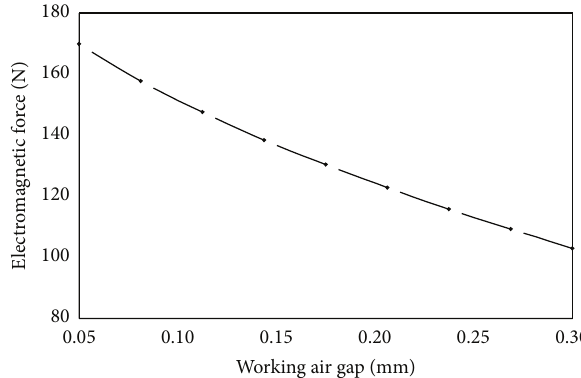
Figure 15: Influence of working air gap on electromagnetic